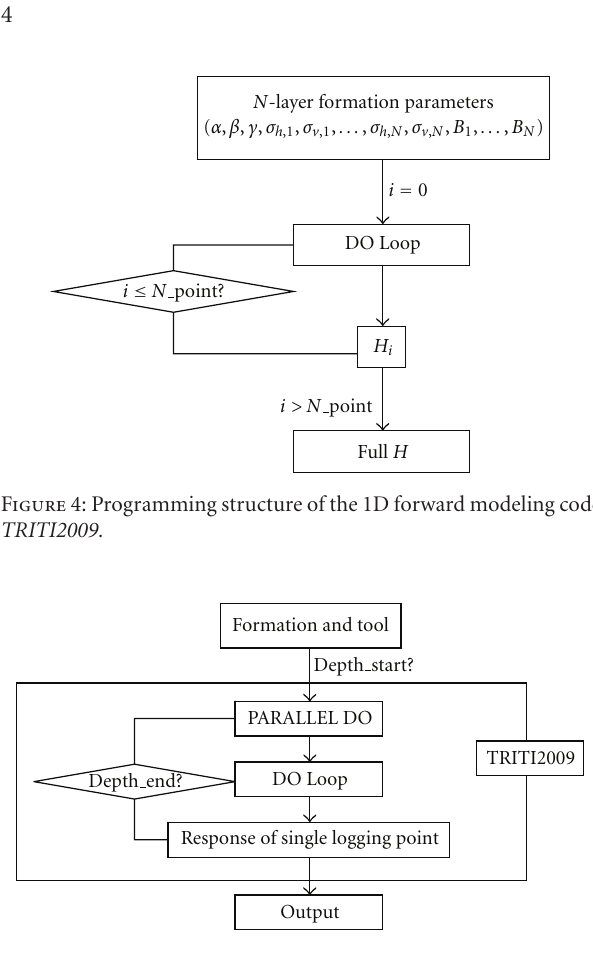
Figure 5: Programming structure of the parallelized 1D forward model TRITI2009.